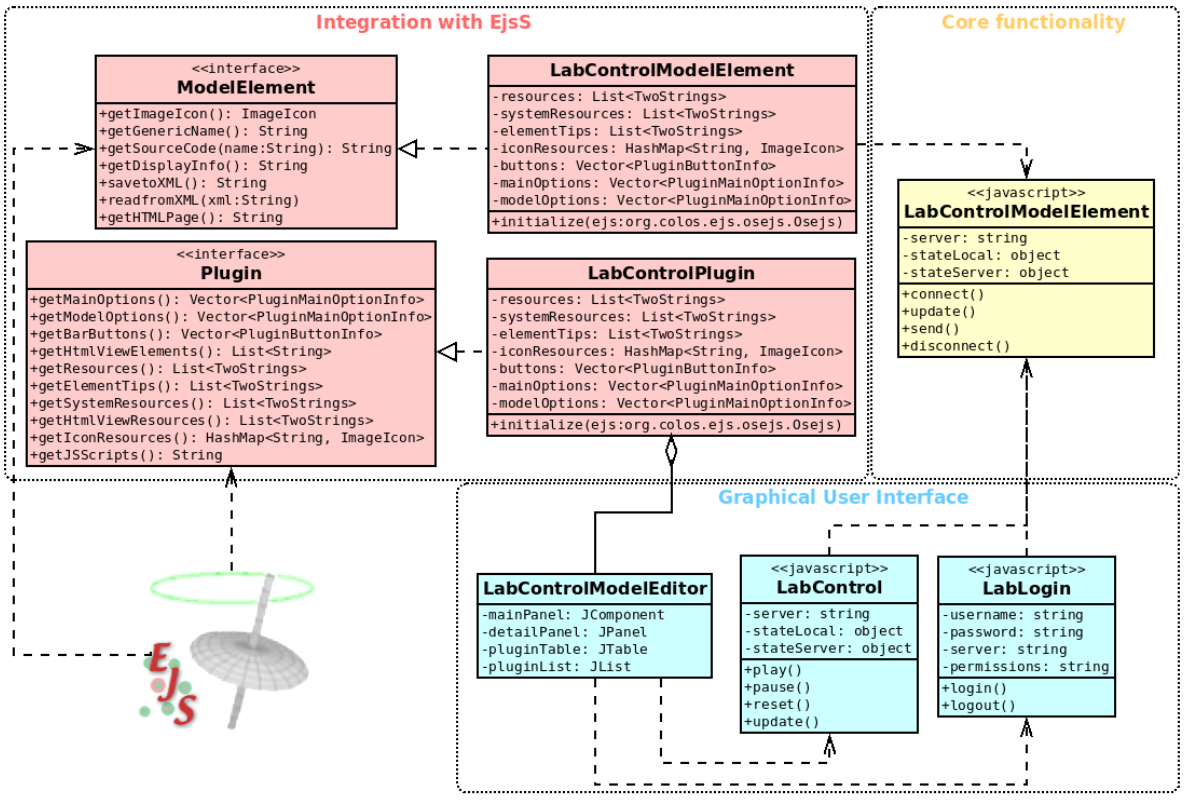
Figure 8. UML class diagram of the Remote Laboratory